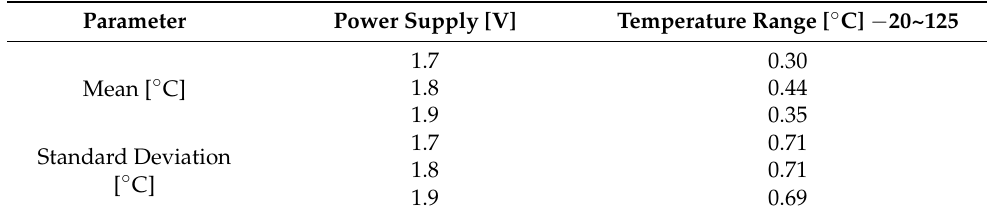
Table 1. Mean and standard deviation of the temperature error for 20 measured DTS